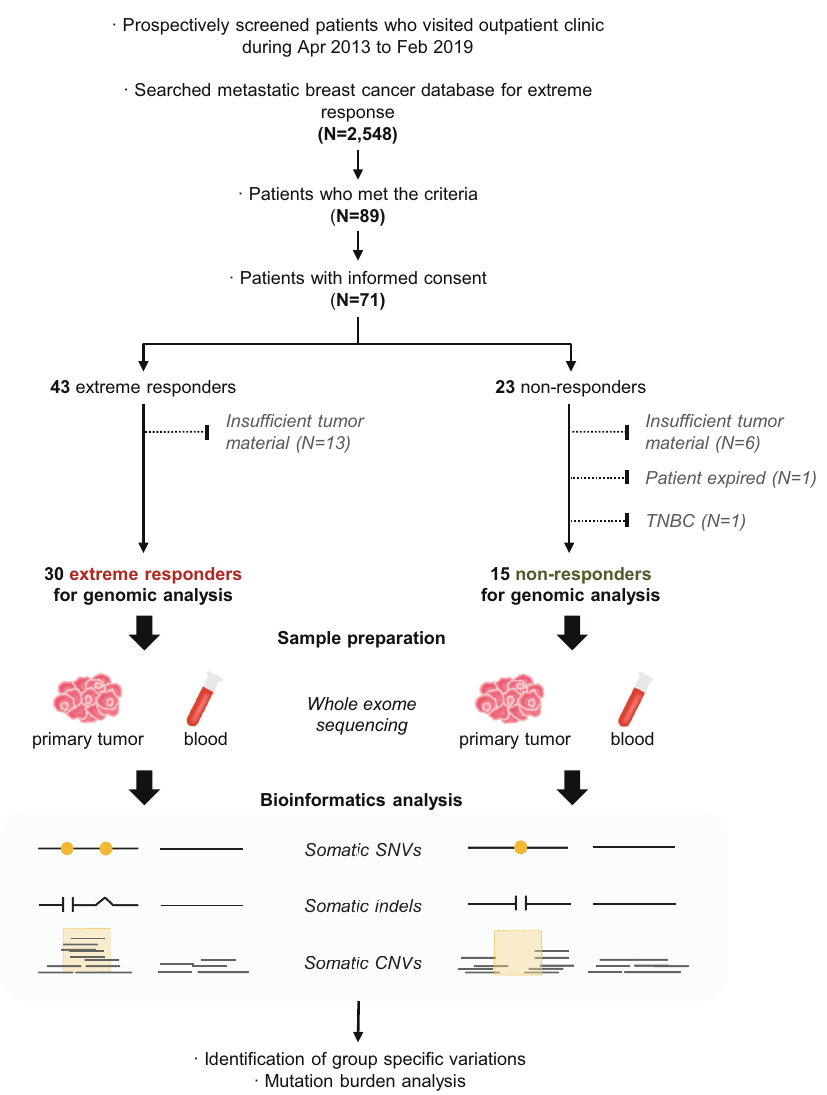
Fig. 1 Schematic diagram of the study protocol. The overall study procedure is depicted to show patient enrollment and